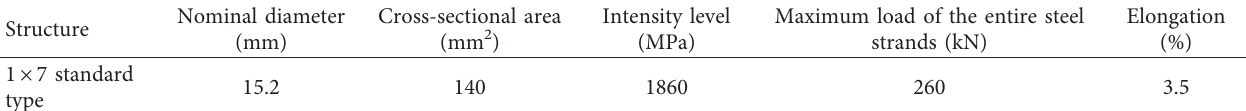
Figure 2: Comparison of inductance coil and prestressed steel hinged wire structure. Table 1: Steel strand parameters.